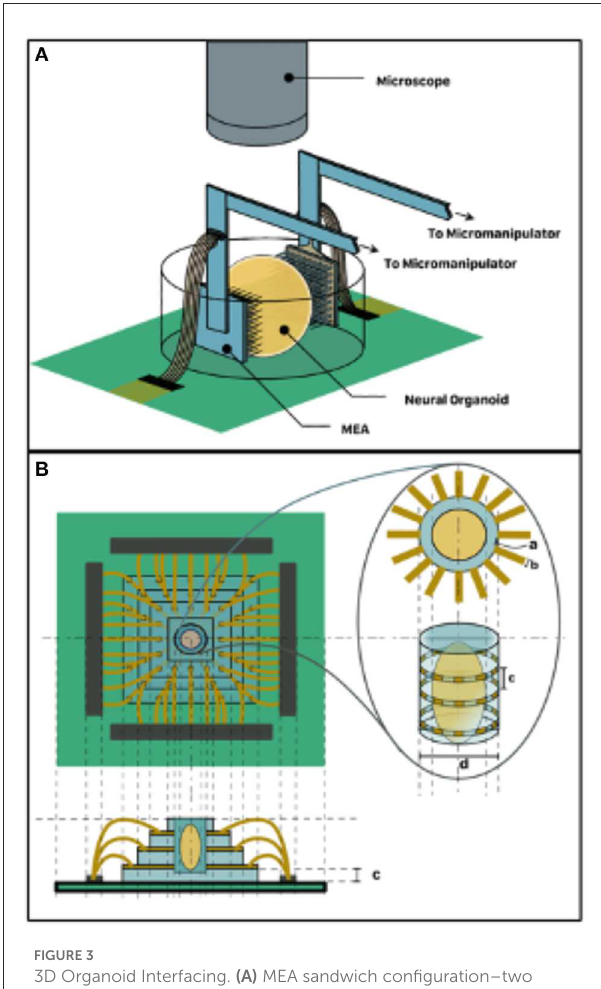
FIGURE3 3D Organoid Interfacing. (A) MEA sandwich configuration–two MEAs assigned input and output respectively impinge the two organoid hemispheres. (B) Organoid well approach suitable for non-invasive interfacing such as